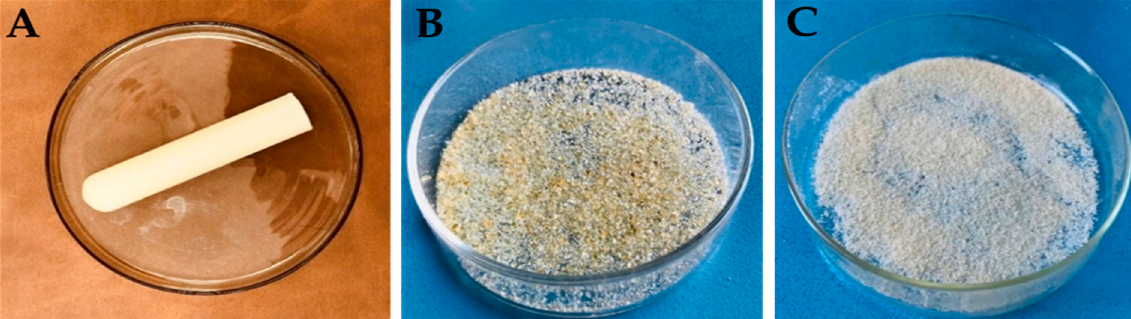
Figure 1. Physical appearance of MU-CHI-Co-Poly (MAA) hydrogel rod ( A ), dried unloaded hydrogel microparticles ( B ), and coated hydrogel microparticles ( C ).